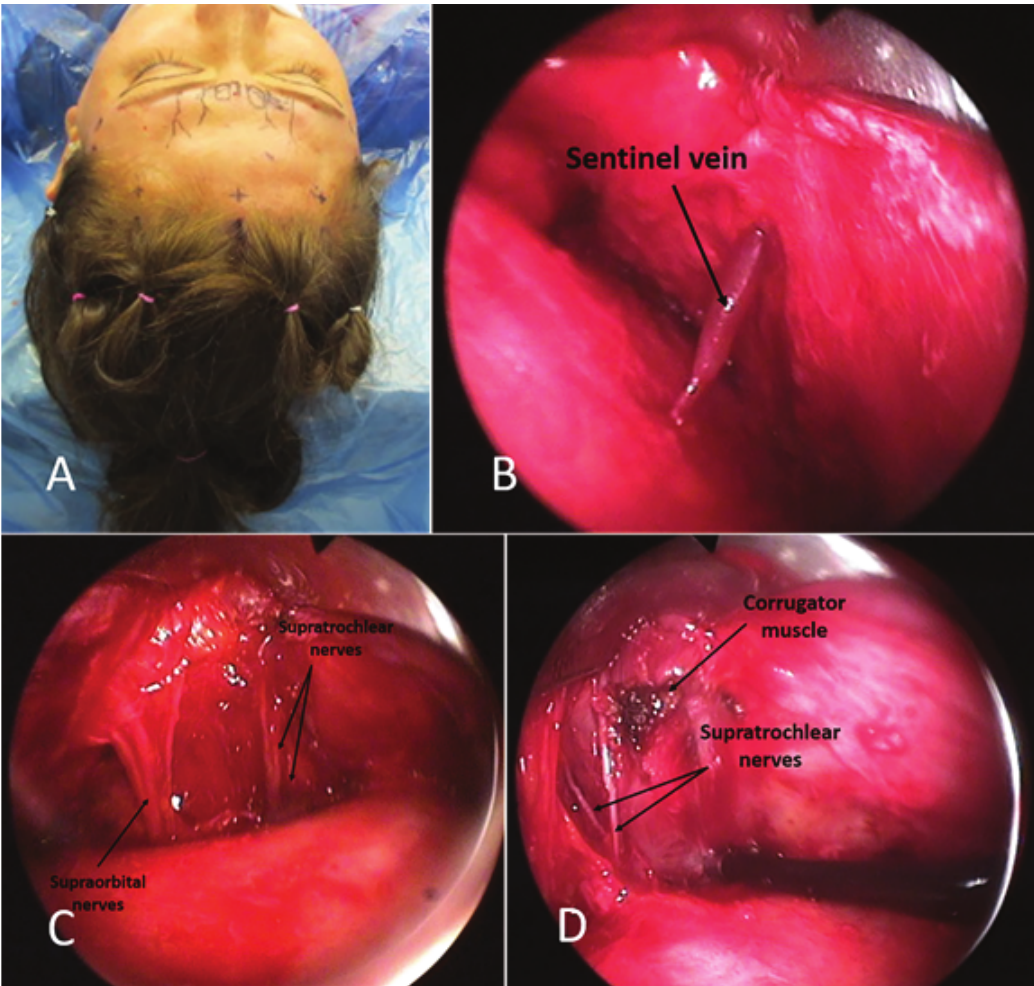
Figure 12. Endoscopic forehead lift. Novice surgeons are recommended to mark the location of corrugator mus- cles, supratrochlear and supraorbital neurovascular bundles before commencing the surgery (A). Sentinel vein is in close proximity to the frontal division of the facial nerve (B). Supratrochlear and supraorbital neurovascular bundles are readily identifiable during endoscopic lift (C). Corrugator muscle is disinserted and cauterized to smoothen the frown lines. Supratrochlear nerves crossing the muscle fibers should be preserved during the muscle disinsertion